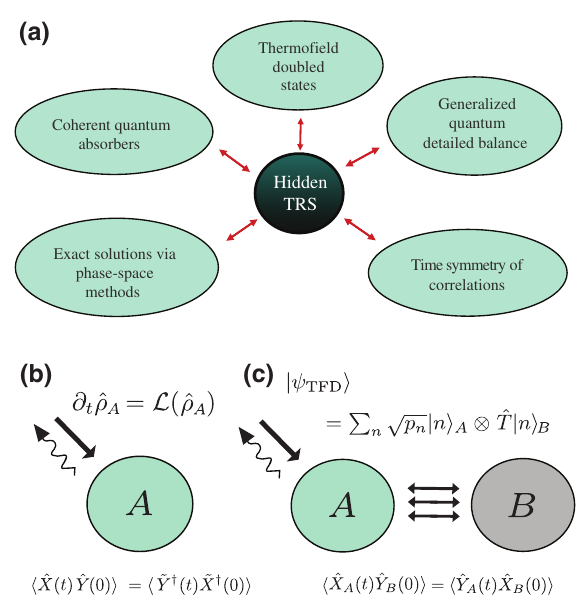
FIG. 1. (a) The concept of hidden time-reversal symmetry helps unify disparate-seeming topics in the study of driven- dissipative quantum systems. (b) A driven-dissipative system described by a Lindblad master equation. The conventional definition of quantum detailed balance is formulated as a time symmetry of steady-state correlation functions. (c) Hidden TRS is a symmetry ensuring that correlation functions of a doubled version of the original system, prepared in a thermofield double state, are time symmetric. It is defined by an antiunitary operator ˆ T . Hidden TRS can hold even when the correlation-function sym- metry in (b) fails; it also enables a powerful method for finding exact solutions.